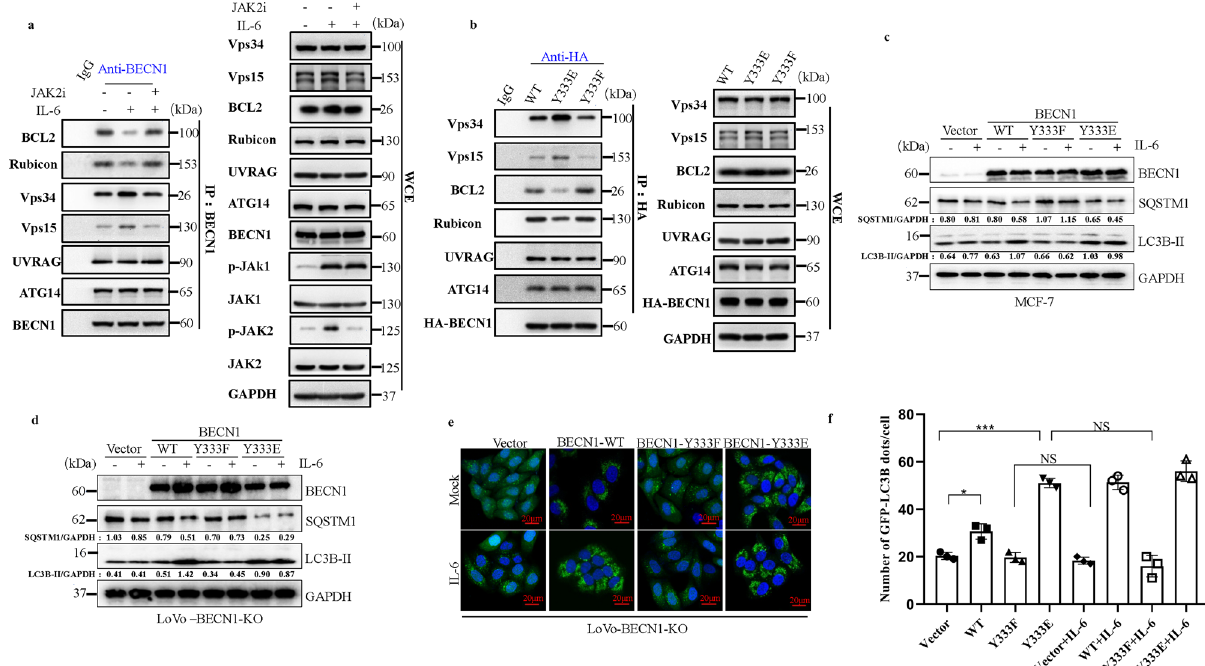
Fig. 4 BECN1 Y333 phosphorylation is required for IL-6-induced autophagy. a IP analyses for VPS34, VPS15, BCL2, Rubicon, UVRAG, ATG14, and BECN1 in HEK293T cells in the absence or presence of IL-6 (20 ng/ml) for 12 h or in the absence or presence of CHZ868 (0.2 μ M) treatment for 12 h. Western blotting was performed on WCEs (lower panels). b Co-IP analyses for HA-BECN1, VPS15, BCL2, Rubicon, UVRAG, ATG14, and VPS34 in HEK293T cells expressing HA-BECN1 WT, HA-BECN1 Y333F, or HA-BECN1 Y333E. Western blotting was performed on whole-cell lysates (lower panels). c Western blot analyses for BECN1, SQSTM1, and LC3B-II in MCF-7 cells expressing a vector control (Vector), HA-BECN1 WT, HA-BECN1 Y333F, or HA-BECN1 Y333E in the absence or presence of IL-6 (20 ng/ml) for 12 h. d Western blot analyses for BECN1, SQSTM1, LC3B-II in LoVo-BECN1-KO cells expressing a vector control (Vector), HA-BECN1 WT, HA-BECN1 Y333F, or HA-BECN1 Y333E in the absence or presence of IL-6 (20 ng/ml) for 12 h. e , f IF analyses for GFP- LC3B3 puncta in LoVo-BECN1-KO cells expressing a vector control (Vector), HA-BECN1 WT, HA-BECN1 Y333F or HA-BECN1 Y333E in the absence or presence of IL-6 (20 ng/ml) for 12 h. Confocal microscopy images are shown ( n = 3 independent experiments) ( f ). Quanti fi cation of the number of GFP- LC3B puncta is shown in the right panel ( g ). * P < 0.05, *** P < 0.001. NS not signi fi cant. Scale bars, 20 μ m. The values are presented as the mean ± s.d.; p values (Student ’ s t test, two-sided) with comparisons made to the control or different indicated groups are shown. Western blots are representative of two independent experiments. WCE whole-cell extract. Source data are provided in the Source Data fi